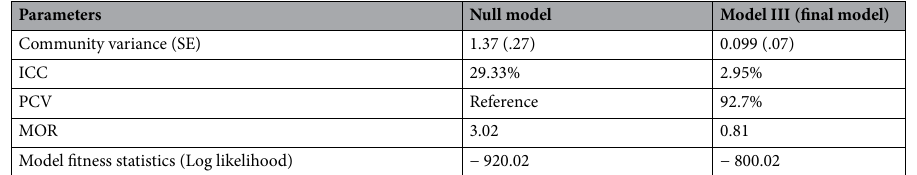
Table 3. Random effect and model of two-level mixed effect logistic regression models predicting Teenage pregnancy, Ethiopia 2016. ICC : intra class correlation, PCV : proportional change in variance, MOR : median odds ratio